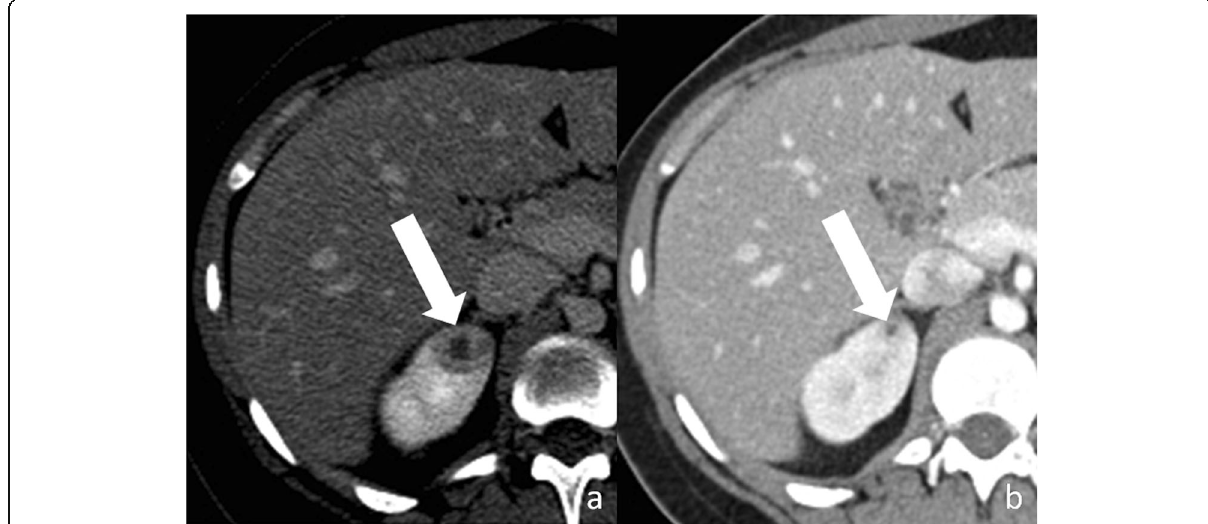
Fig. 10 Renal abscess. a Axial contrast-enhanced CT shows a cystic lesion (arrow) with a peripheral, thick, enhancing, wall. b Axial contrast- enhanced CT obtained 3 months after antibiotic therapy shows decrease in size of the